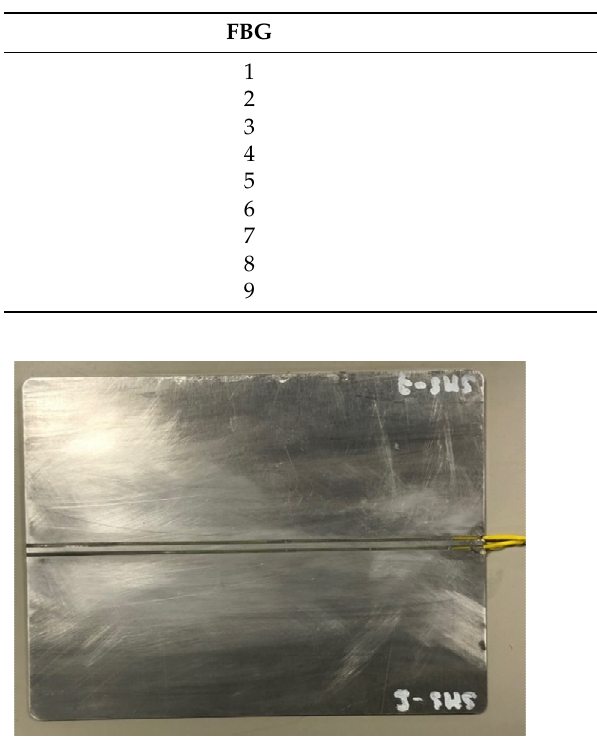
Table 1. Sensor sensitivity for each FBG on the rail.